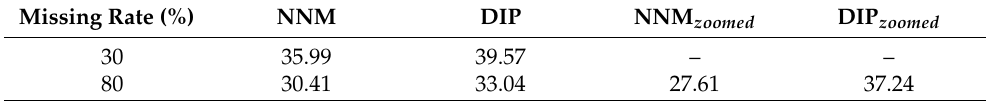
Table 6. PNSR comparison of data recovery methods for pixel-wise missing case for real data-II. Missing Rate